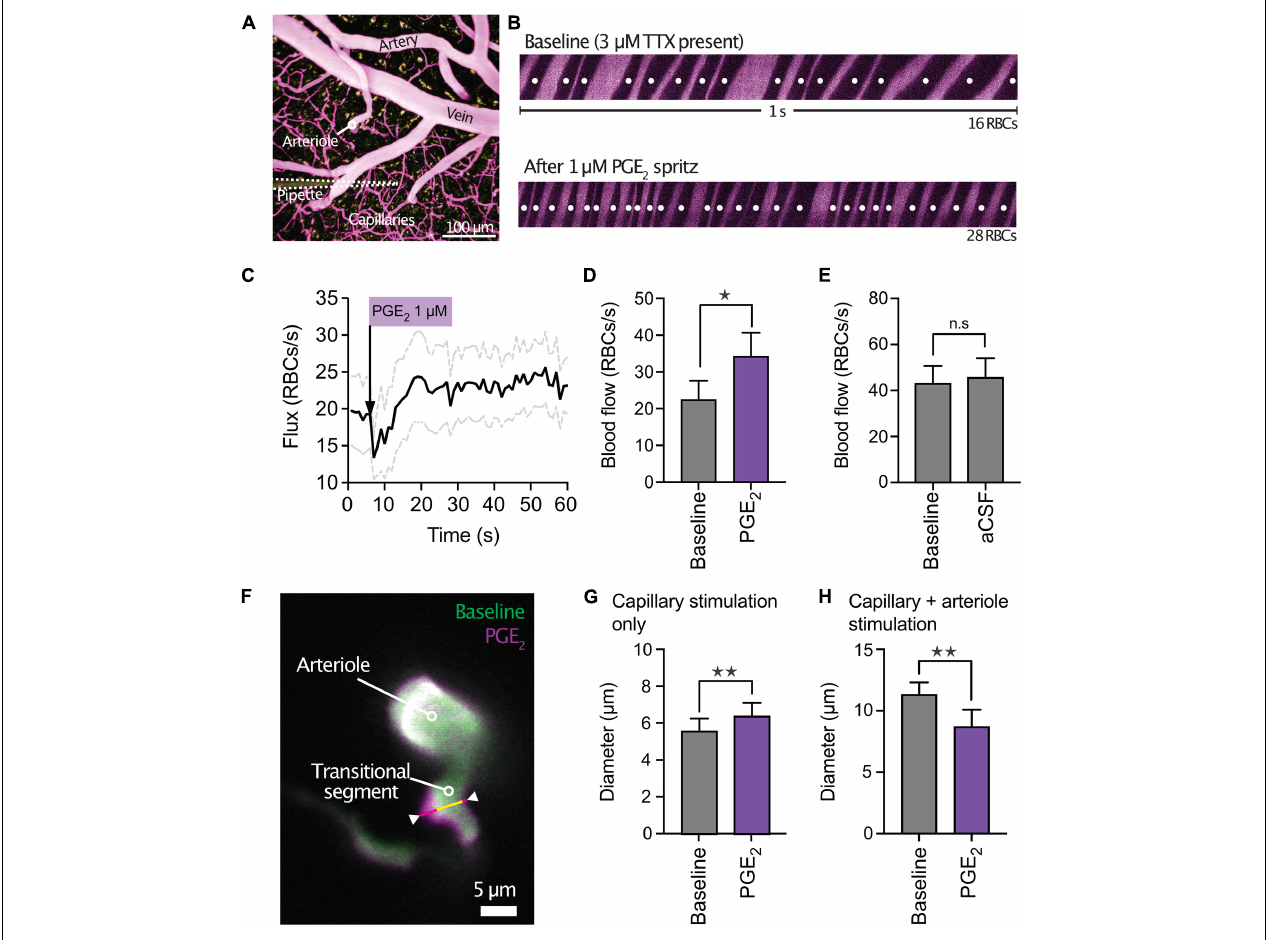
FIGURE 4 | PGE 2 causes capillary hyperemia in vivo . (A) Micrograph of mouse cortical vasculature showing a micropipette containing PGE 2 and TRITC-dextran (yellow) in close apposition to a capillary (FITC-dextran, purple). (B) Red blood cell (RBC) flux was measured by high-frequency line scanning over a period of 1 min at baseline (top panel) and after application of 1 µ M PGE 2 (lower panel) onto a capillary. RBCs appear as black streaks in plasma (purple). (C) Average traces (black line) plus SEM (gray lines) showing the increase in RBC flux to PGE 2 . The dip immediately following the ejection of PGE 2 is caused by momentary pressure on the capillary wall. (D) Summary data of RBC flux showing significant hyperemia following capillary stimulation with 1 µ M PGE 2 ( n = 14 experiments, 6 mice, * P < 0.05, paired Student’s t -test). (E) In contrast, ejection of aCSF vehicle onto capillaries had no effect on RBC flux ( n = 9 experiments, 5 mice, P > 0.05, paired Student’s t -test). (F) Overlay showing the diameter of a penetrating arteriole and the transitional segment to the capillary bed at baseline (green) and after PGE 2 ejection onto a downstream capillary (magenta). The upstream dilation was most prominent in the region highlighted by the white arrowheads. (G) Summary data showing upstream dilation to capillary ejection of PGE 2 ( n = 5 experiments, 4 mice, ** P < 0.01, paired Student’s t -test). (H) In contrast, simultaneous stimulation of both capillaries and arterioles with